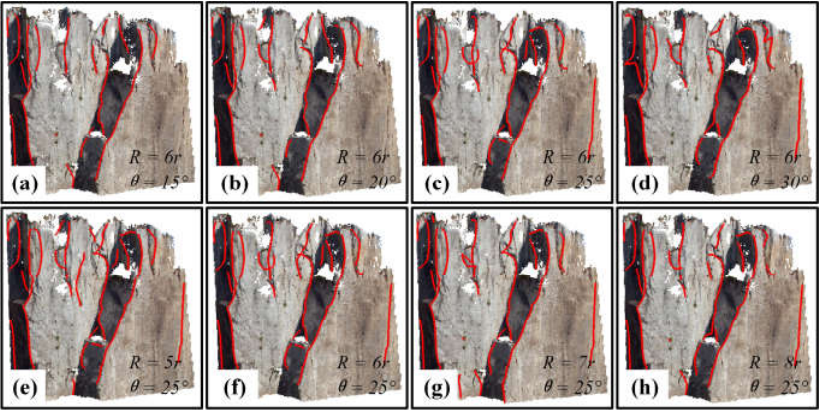
Figure 16. Comparison of different neighborhood radius thresholds and direction thresholds. ( a – d ) Results of different angle thresholds; ( e – h ) results of different neighborhood radius